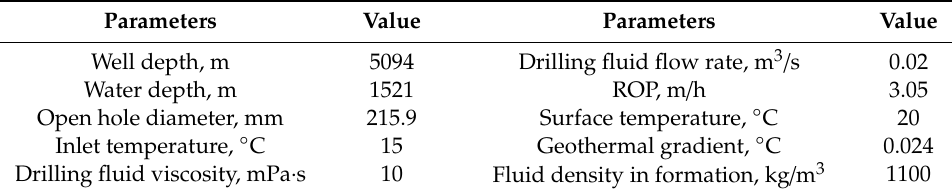
Table 1. The Basic parameters of the